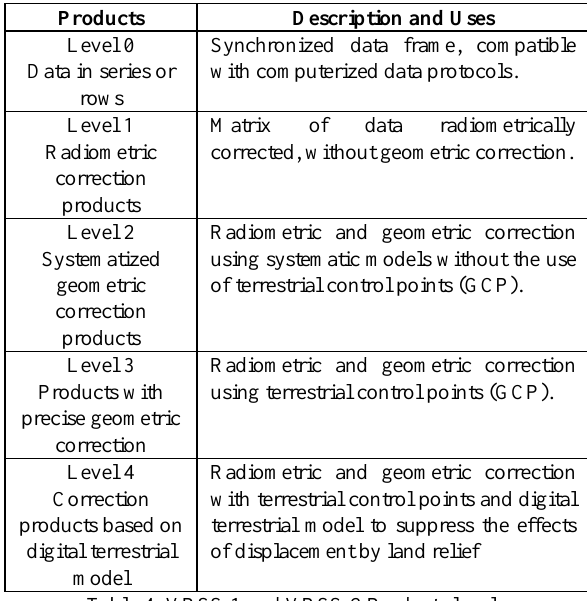
Table 4. VRSS-1 and VRSS-2 Products levels